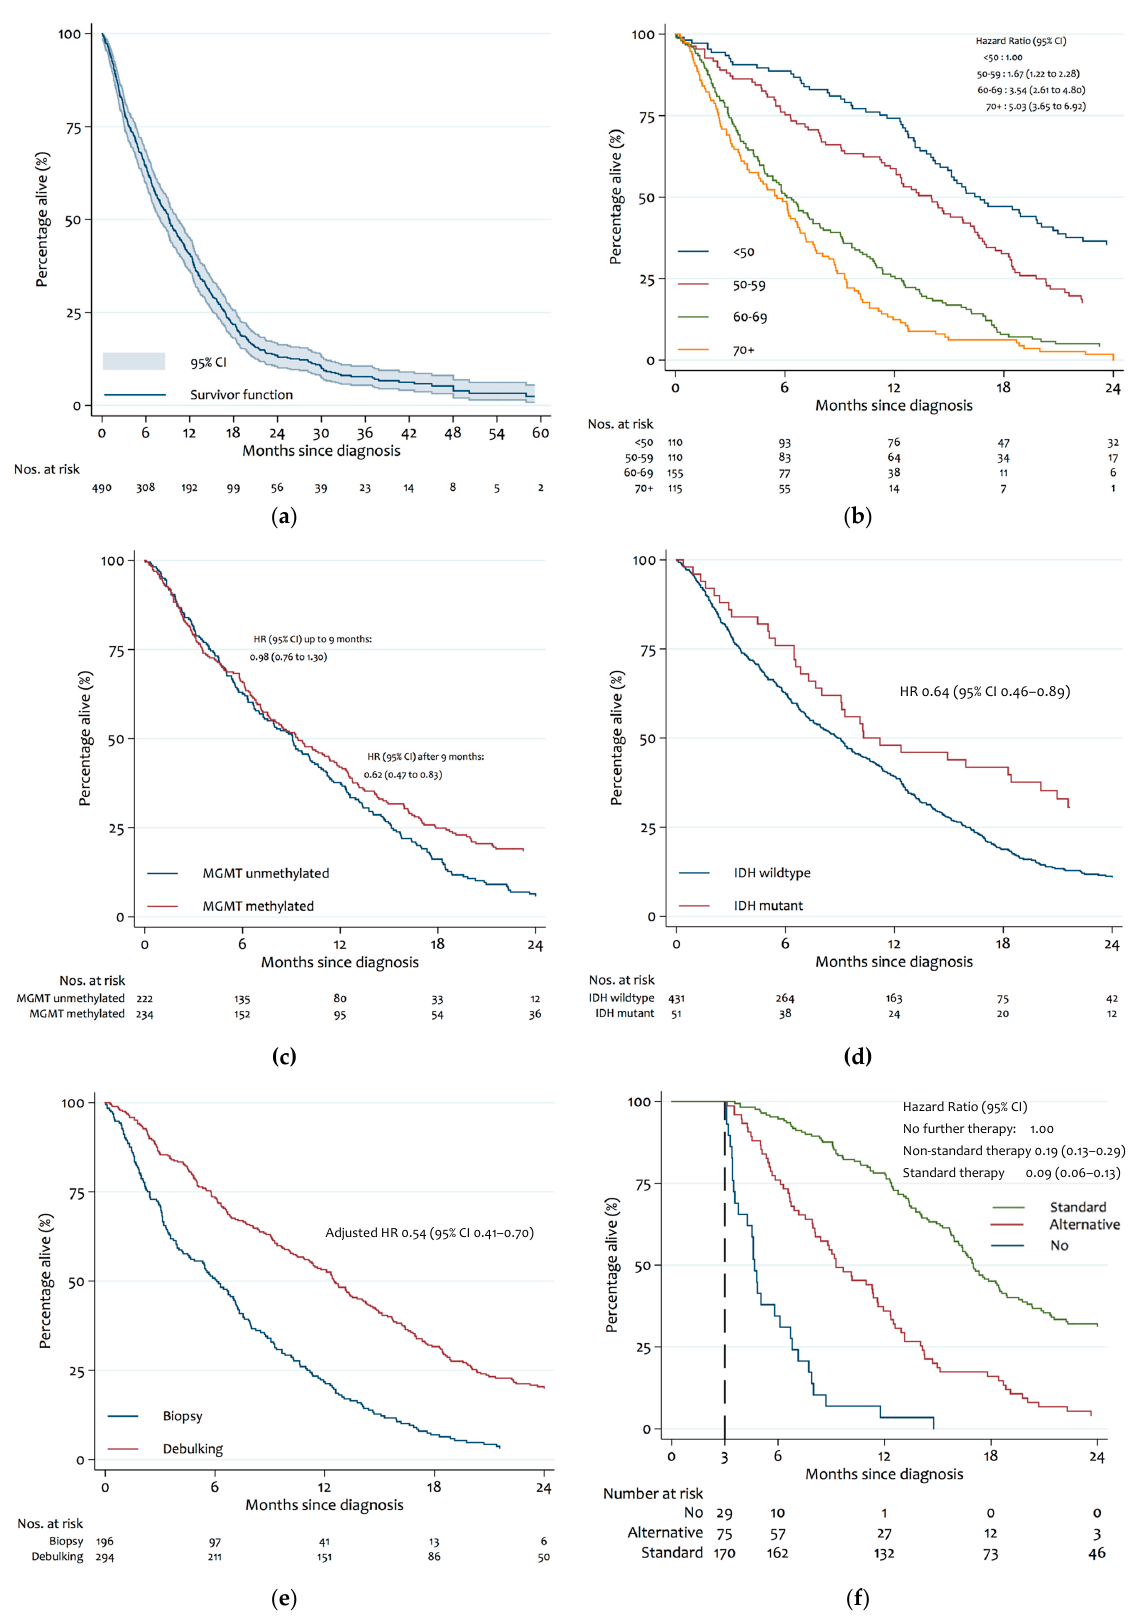
Figure 2. Kaplan − Meier survival estimates: ( a ) overall survival; ( b ) age at diagnosis; ( c ) tumour IDH mutation; ( d ) tumour MGMT methylation; ( e ) debulking surgery vs. biopsy alone; ( f ) chemo/radio- therapy after